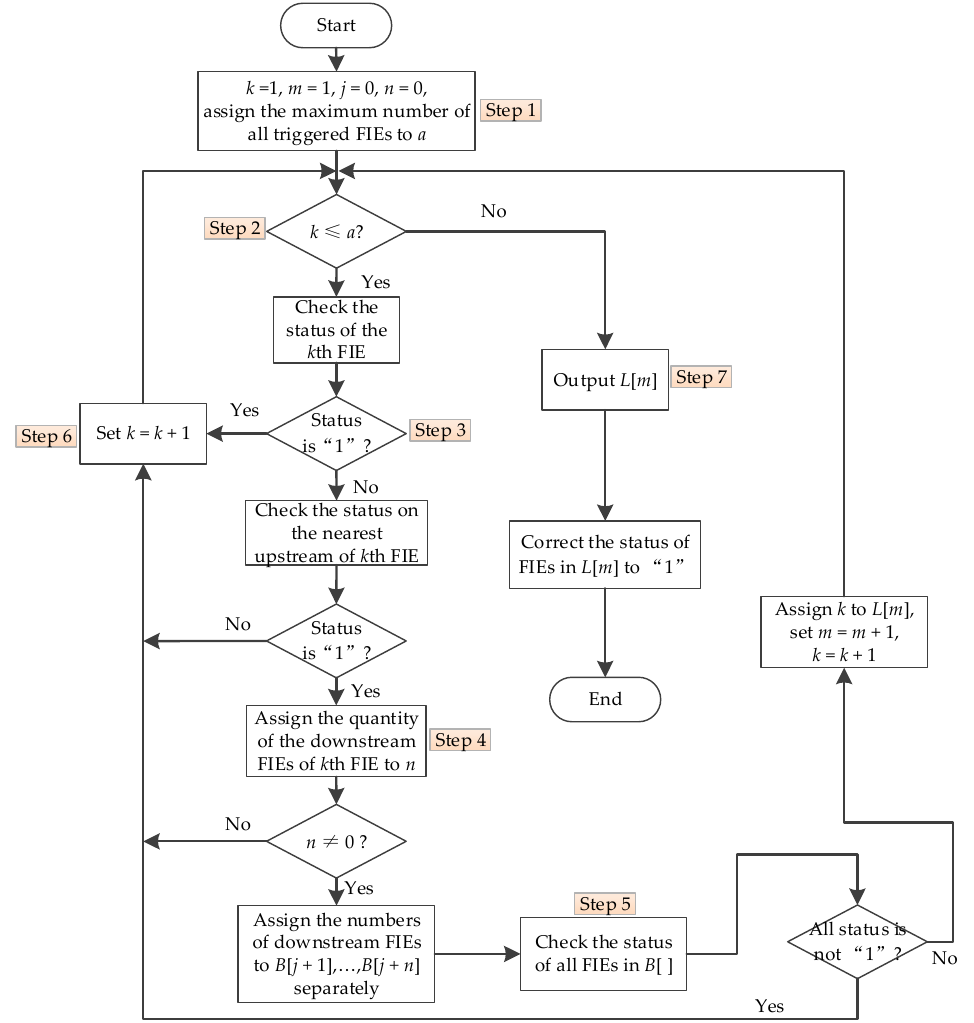
Figure 4. Flow chart of the information loss detection algorithm.